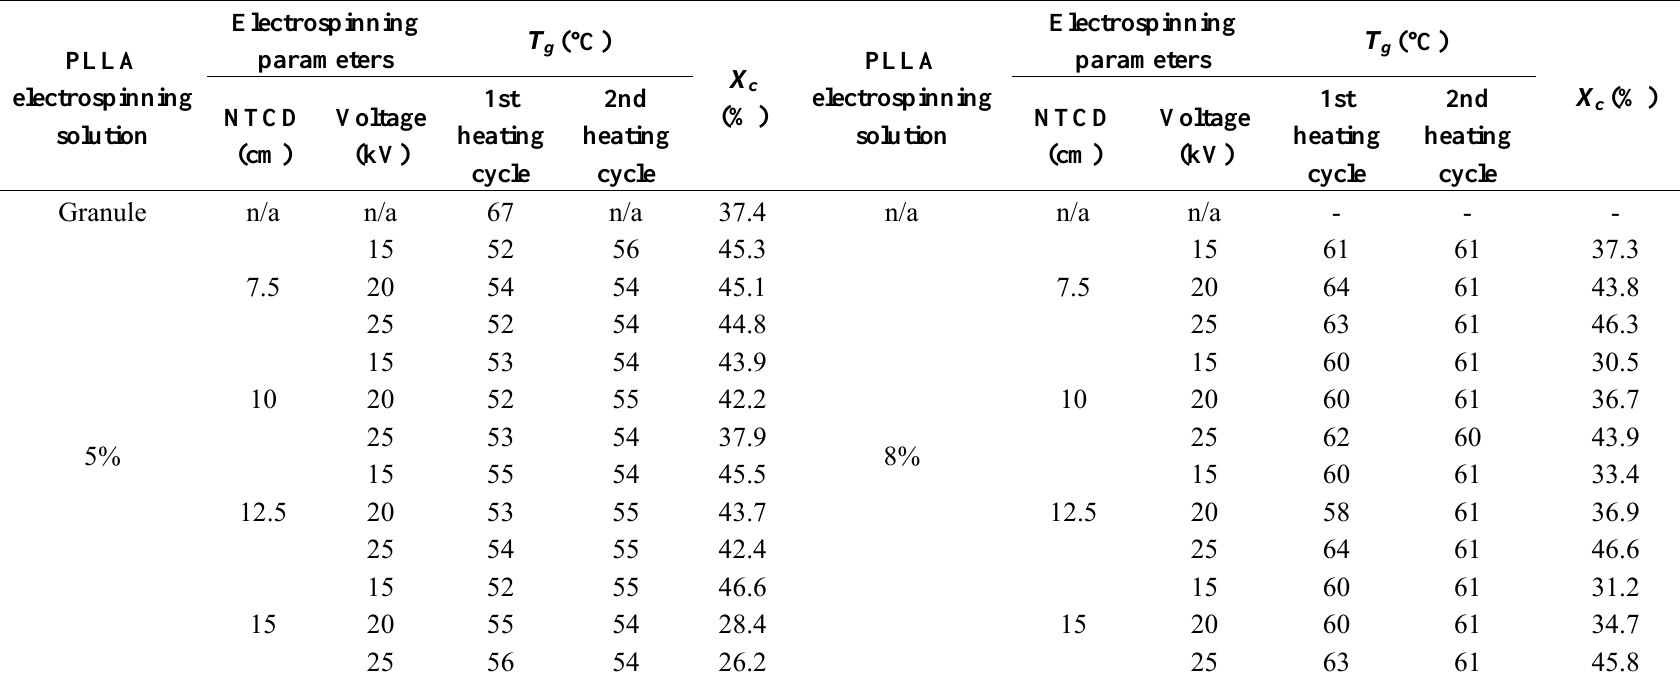
and X with electrospinning parameters. (n/a–not applicable; X g c